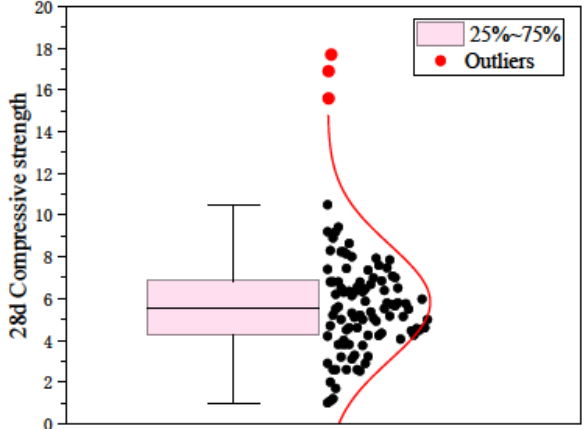
Figure 4: Boxplot of 28d compressive